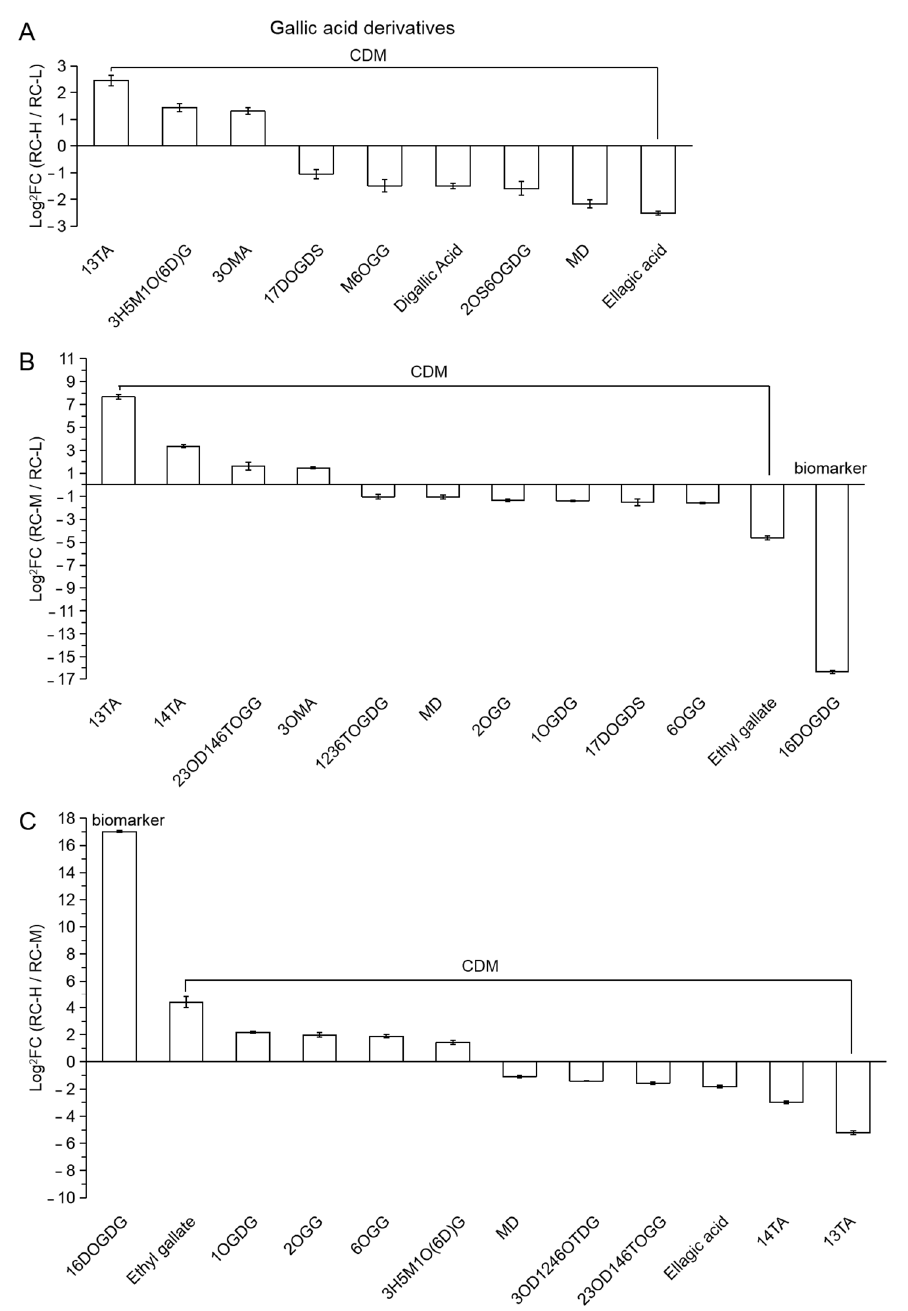
Figure 11. Comparison of differential metabolites of gallic acid derivatives between RC-L, RC-M and RC-H. These were 9 CDMs for RC-H vs. RC-L ( A ), 1 biomarker and 11 CDMs for RC-M vs. RC-L ( B ), and 1 biomarker and 11 CDMs for RC-H vs. RC-M ( C ). Upregulation denotes that the content of a metabolite in RC increased with elevation between two altitudes, and the opposite for downregulation. The Y-axis is shown as Log 2 FC values for the convenience of visual presentation (Note: The up-amplitude in the text refers to the FC value). The X-axis denotes metabolite names. As shown in Figure 11C, the 1biomarker and 11CDMs in RC-H vs. RC-M